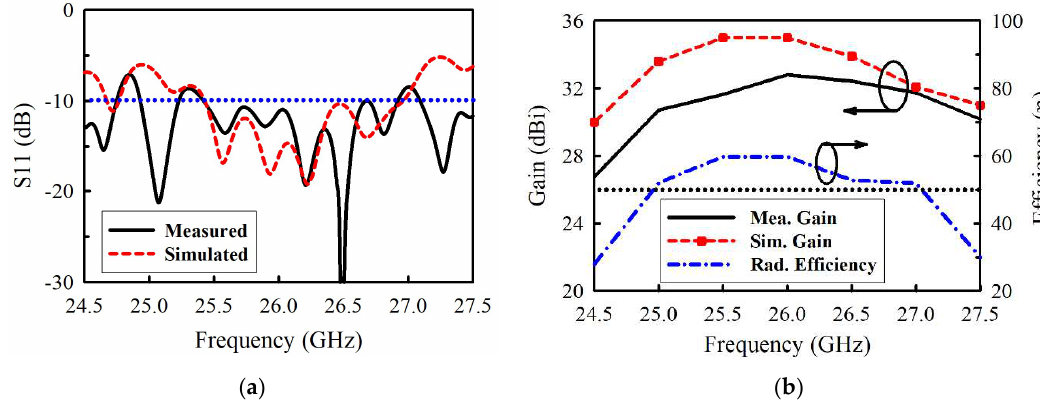
Figure 10. ( a ) Reflection coefficient. ( b ) Gain and efficiency.